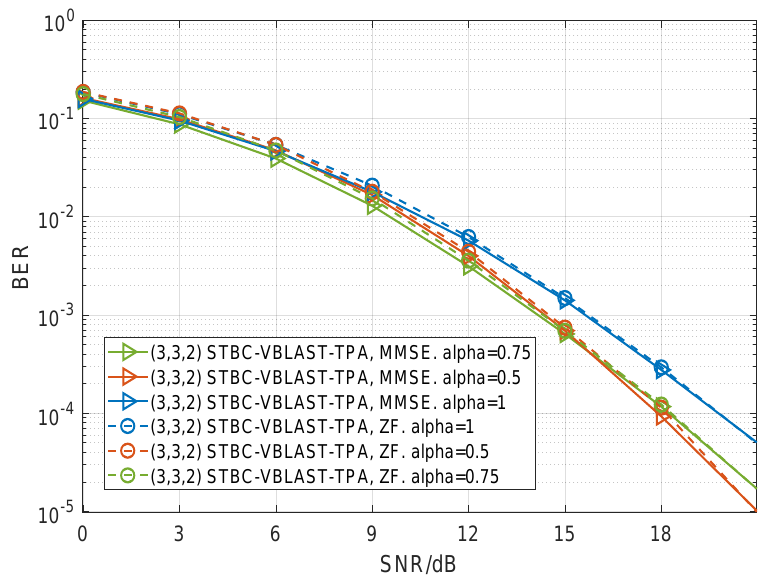
Figure 7. Performance comparisons of the ( 3,3,2 ) STBC-VBLAST-TPA system with α = 1, α = 0.5 and α = 0.75, employing MMSE and ZF decoders.